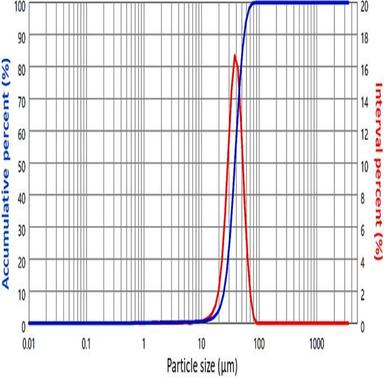
Particle size distribution of the X2-Lu2SiO5 feedstocks.